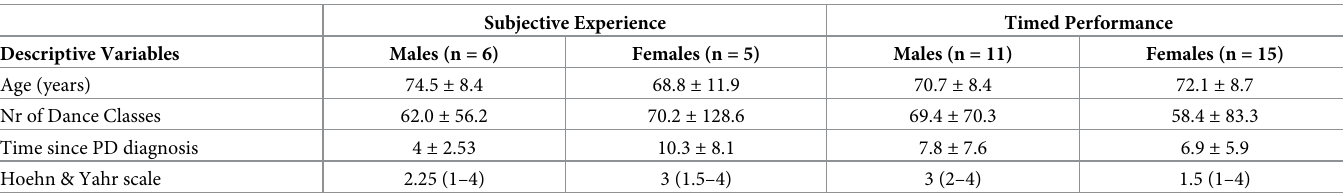
Table 1. Participant